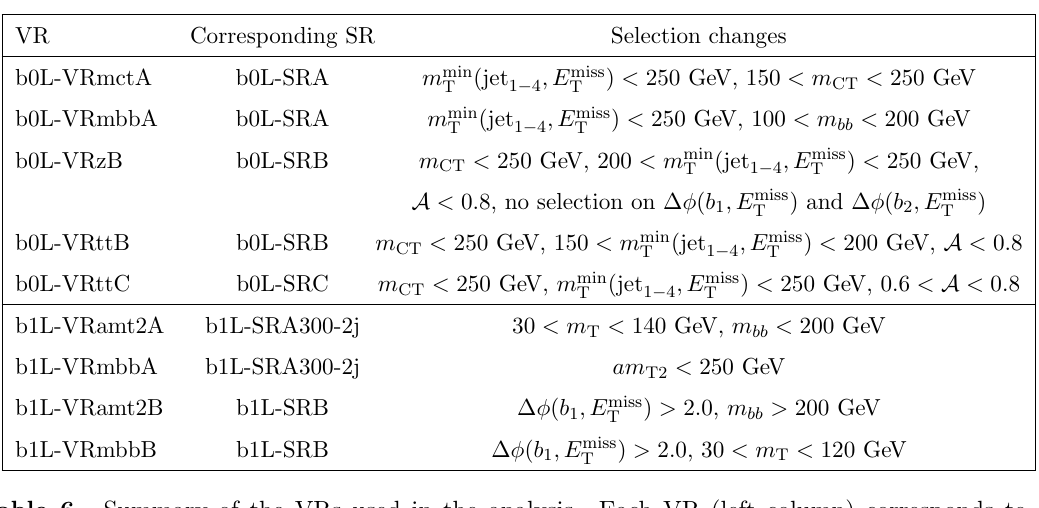
Table 6. Summary of the VRs used in the analysis. Each VR (left column) corresponds to a SR (middle column) de(cid:12)ned in tables 1 and 2, with a few selection requirements changed (right column) to ensure the selection has low e(cid:14)ciency for the expected